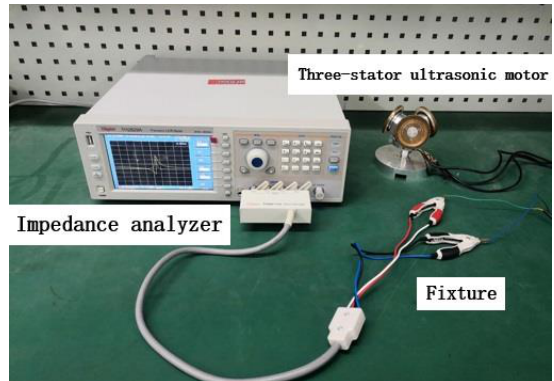
Figure 11. Schematic diagram of impedance analysis experimental device.